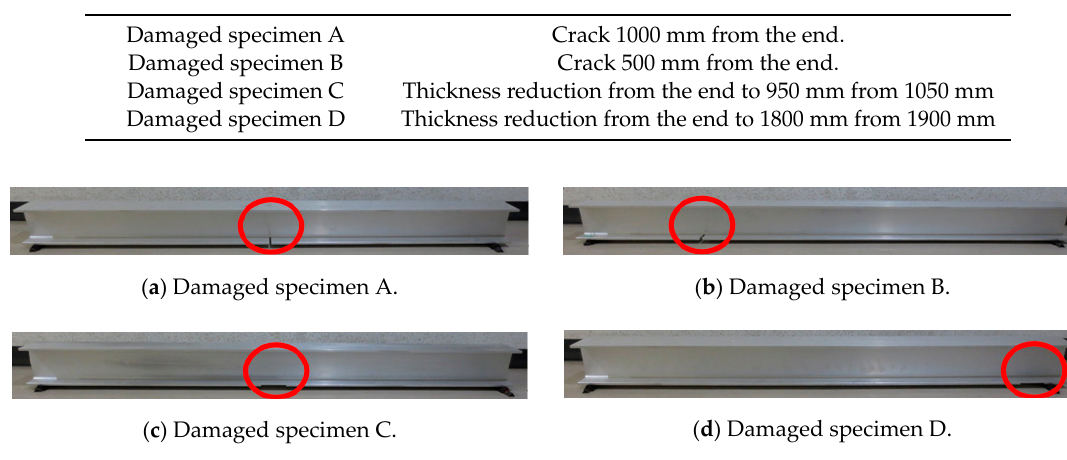
Figure 5. Cross-sectional dimensions of the I-beams. Table 2. Damage to the test specimens.